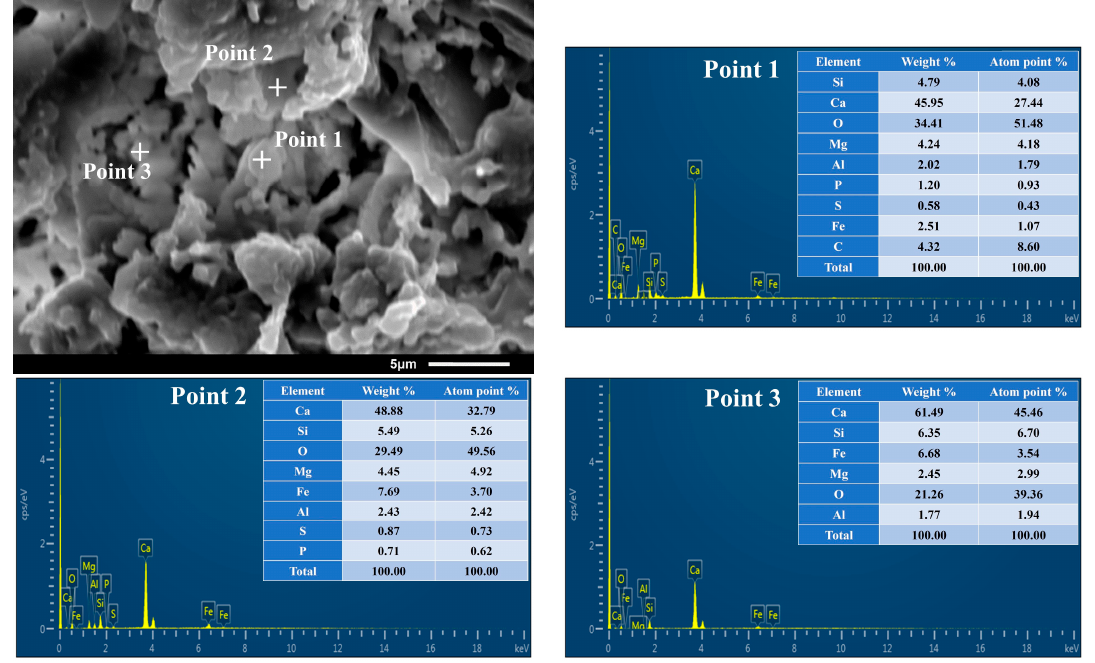
Figure 3. SEM-EDS analysis of internal morphology of the ceramsite. Table 1. Chemical composition of ceramsite samples (excluding toner).